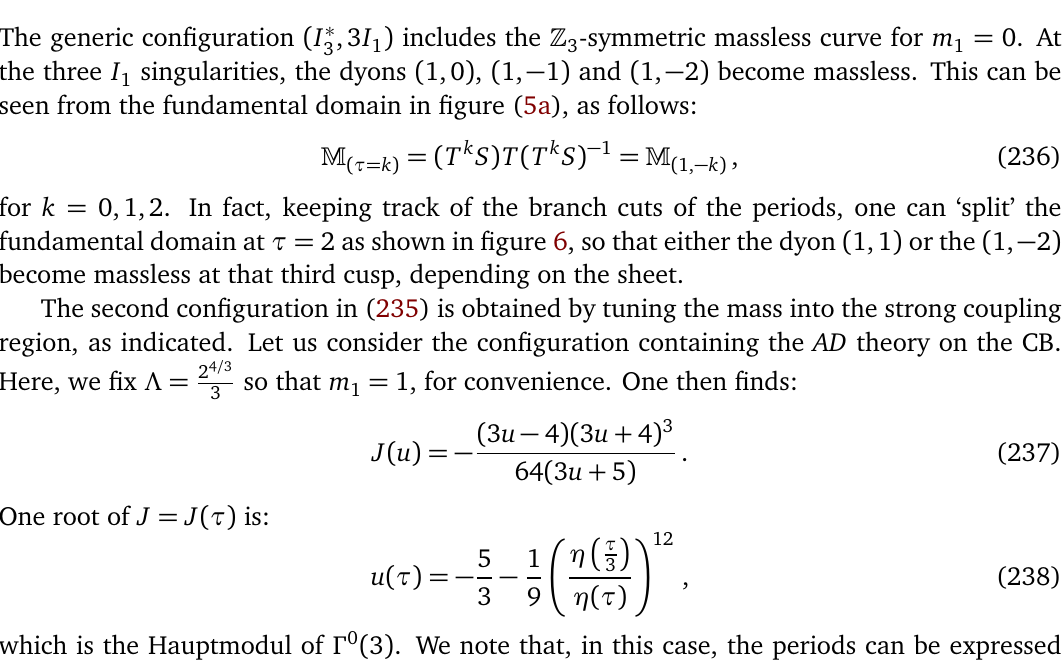
Figure 6: Fundamental domain for the massless 4 d SU ( 2 ) N branch cut of the periods indicated by the dashed line. We also indicate the BPS particles becoming massless at the I